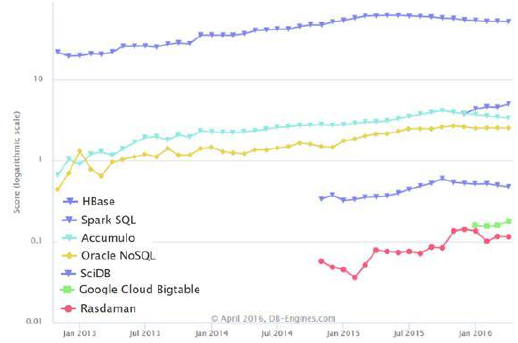
Fig.1. Comparison of the DB engines according to DB- Engines Ranking from April 2016 (1.HBase, 2. Spark, 3. Accumulo, 4. Oracle NoSQL, 5. SciDB, 6. Google Cloud